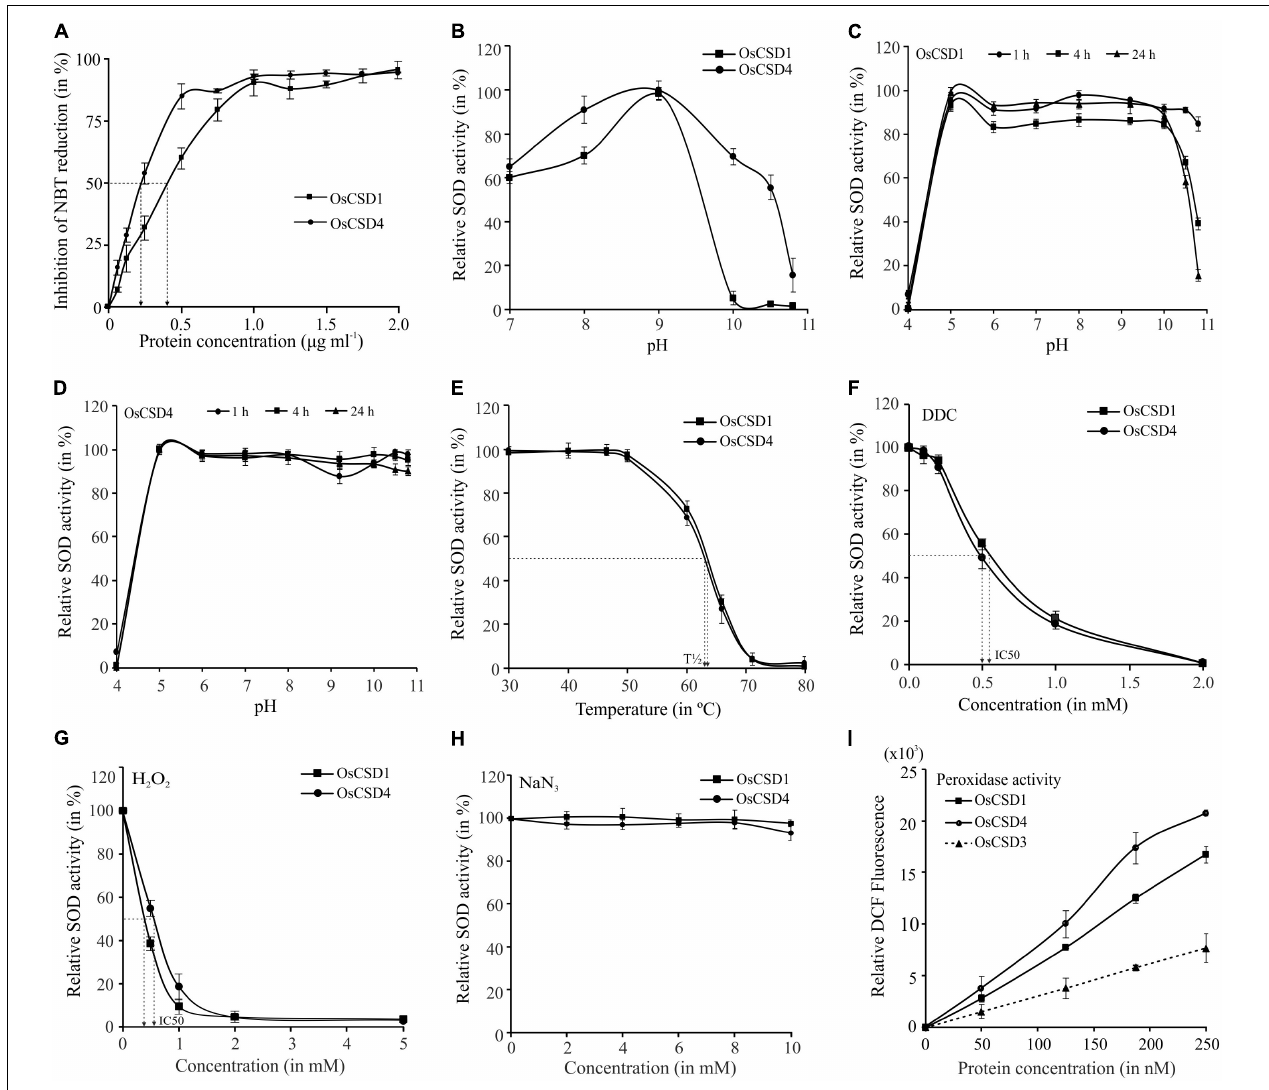
FIGURE 5 | Specific activity, effect of pH, and temperature. (A) Estimation of specific activity: increasing protein amount (0–2 µ g ml − 1 ) was used for SOD assay, and % inhibition of NBT reduction was measured to determine the SOD activity (1 U of SOD activity—amount of protein required to inhibit the NBT reduction by 50%). (B) Optimum pH: SOD activity of OsCSDs was assayed at different pH (range: 7.0–10.8) and relative SOD activity was estimated by considering the maximum activity as 100%. (C,D) Effect of pH on stability: purified OsCSDs were incubated at different pH (range: 4.0–10.8), aliquots were removed at different time points (1–24 h) and assayed for SOD activity (activity before pre-incubation was considered as 100%). (E) Effect of temperature: purified OsCSDs were pre-incubated at different temperatures (30–80 ◦ C) for 1 h, and assayed for SOD activity (activity before pre-incubation was considered as 100%), and plotted as a function of temperature. The vertical dotted lines indicate T1/2 value (temperature at 50% of SOD activity is lost). (F–H) Effect of SOD inhibitors on enzyme activity, diethyldithiocarbamate (DDC, 0–2.0 mM), hydrogen peroxide (H 2 O 2 , 0–5.0 mM), and sodium azide (NaN 3 , 0–10.0 mM). Relative SOD activity was estimated by considering the enzyme activity before pre-incubation with inhibitor as 100%. The arrows indicate IC50 value (concentration that inhibits 50% of SOD activity). (I) For analysis of bicarbonate-dependent peroxidase activity of OsCSDs, dichlorofluorescein (DCF) formation was monitored with increasing amount of protein (0–250 nM). For the SOD activity-based assays, 1U equivalent of purified protein was used, and data are represented as mean ± SD of three independent